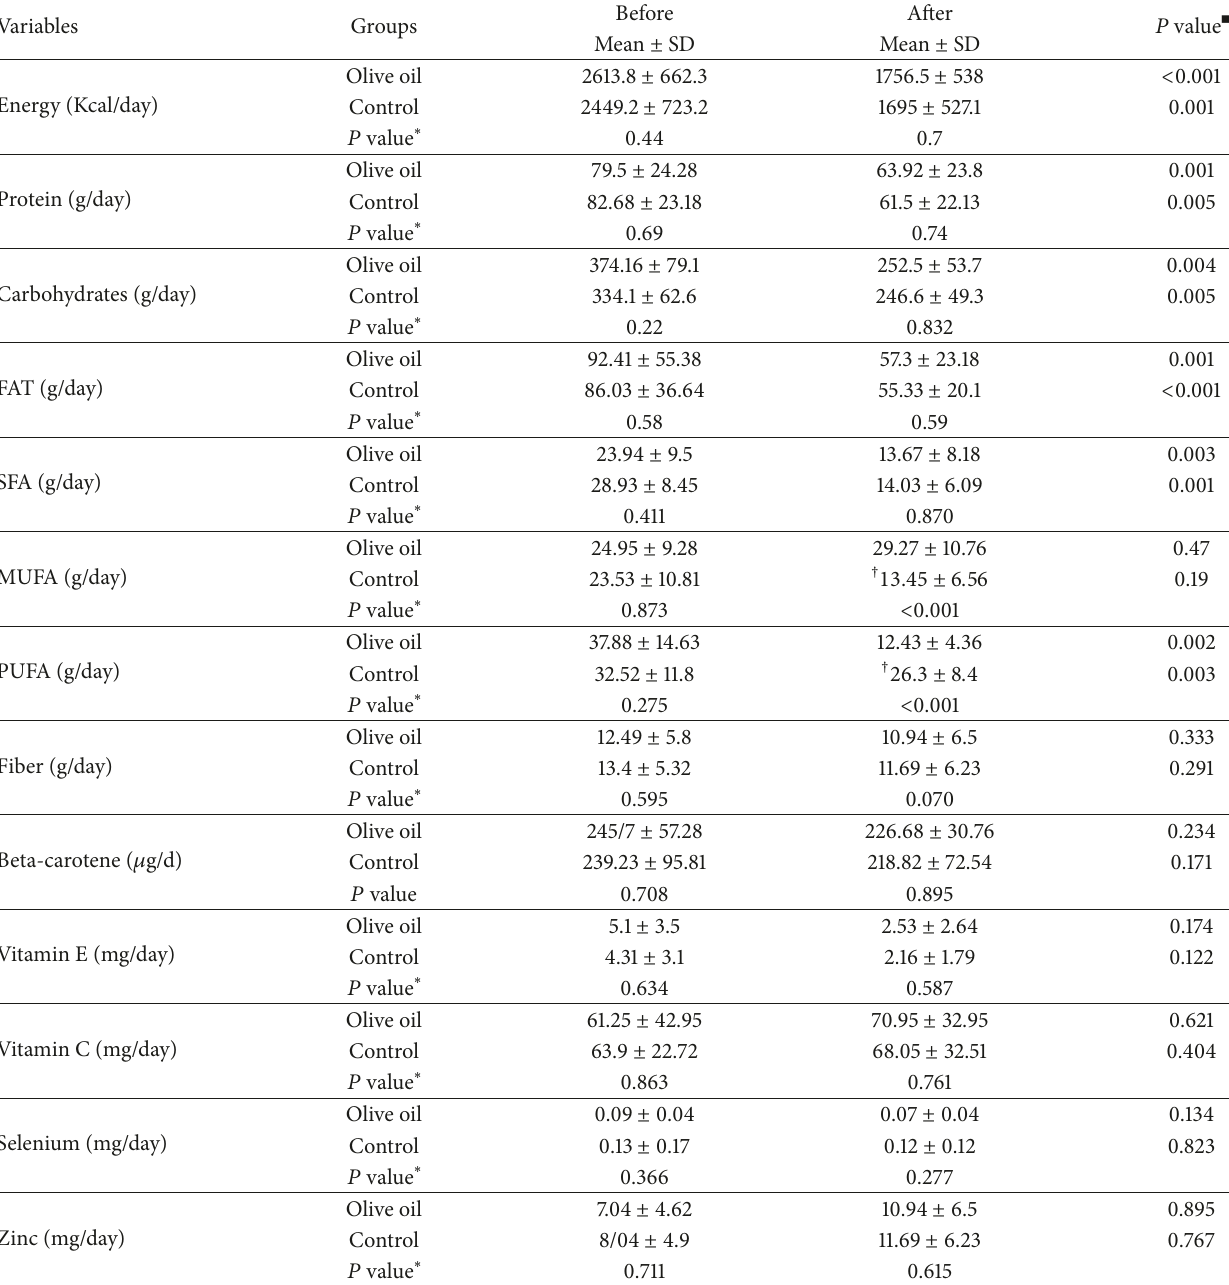
Table 3: Dietary intake of study participants, at baseline and after